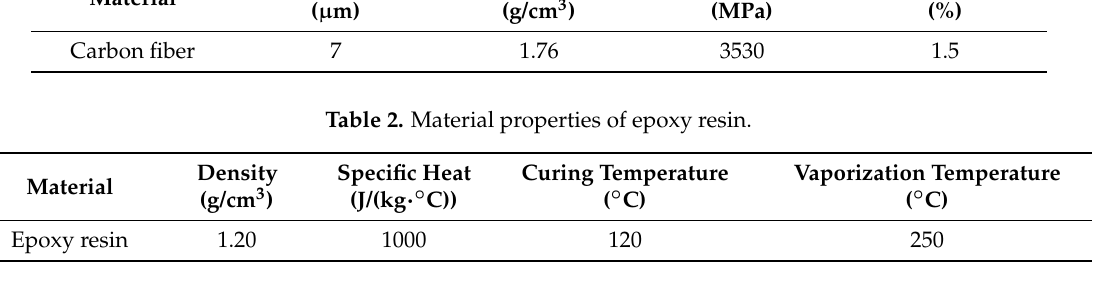
Table 3. Mechanical properties of fully cured 3M DP460